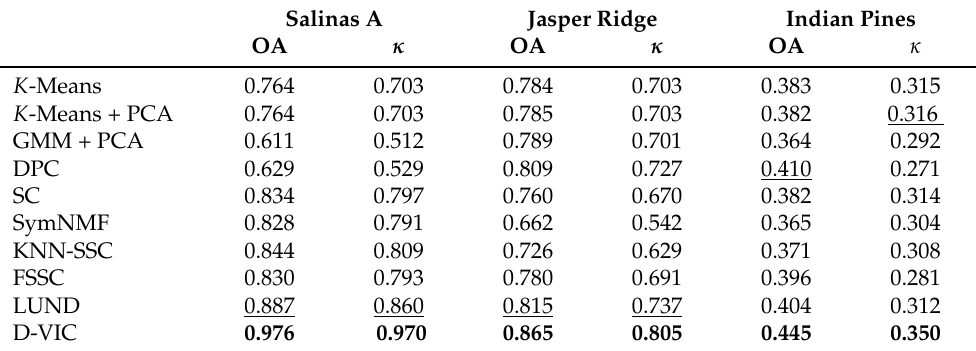
Table 2. Performances of D-VIC and related algorithms on benchmark HSIs. The highest and second-highest performances are bolded and underlined, respectively. D-VIC offers substantially higher performance on all datasets evaluated. Salinas A Jasper Ridge Indian Pines OA